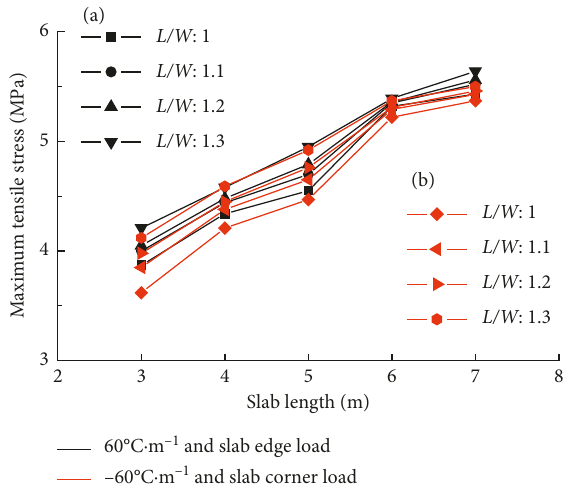
Figure 11: Variations of stresses for different L / W ratios due to the combined effects of different temperature gradients and the aircraft load.